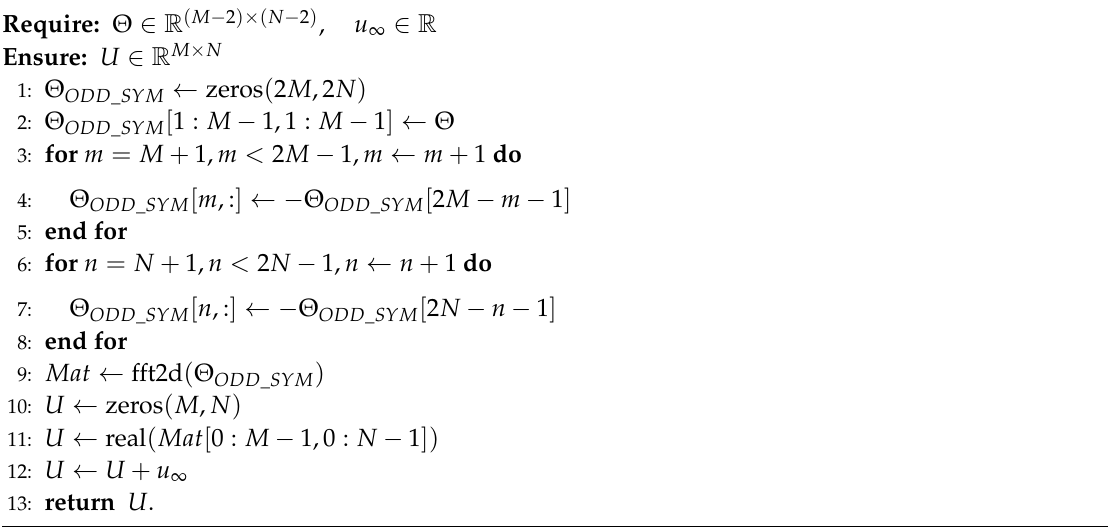
Algorithm 4 Retrieve temperature using 2D FFTs by applying odd sine symmetry and even cosine symmetry to the original